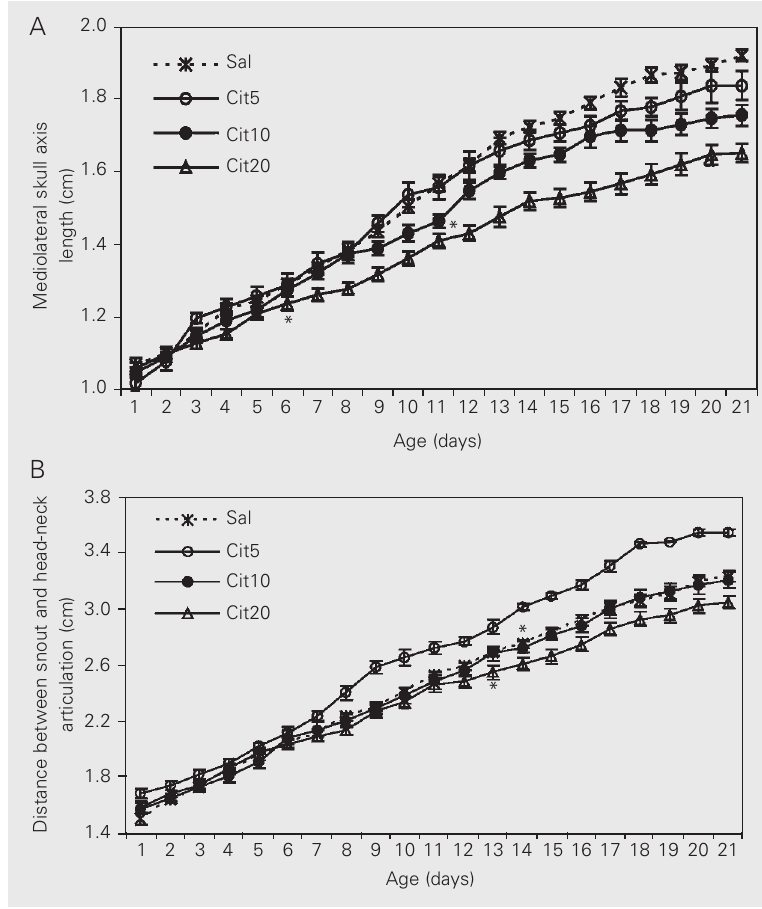
Figure 2. Effect of citalopram on suckling rat mediolateral skull axis length and distance between snout and head-neck articulation. A , Mediolateral skull axis from the 1st to 21st day of life of suckling rats treated with solutions (1 ml/100 g body weight, sc ) of citalopram: 5 mg (Cit5, N = 26), 10 mg (Cit10, N = 27) and 20 mg/kg (Cit20, N = 26) or saline (Sal, N = 27). Comparisons were made by two-way ANOVA for repeated measures for citalopram (F 3,102 = 23.8, P < 0.001) and day of life (F 20,2040 = 1622.1, P < 0.001) and citalopram versus day of life interaction (F 60,2040 = 15.3, P < 0.001) followed by post hoc multiple comparisons (Tukey test) between each citalopram dose and saline. The asterisks indicate the beginning of significant difference in the Cit10 group (P < 0.05) and Cit20 group (P < 0.001) that persisted to the end of the experiment. B , Distance between snout and head- neck articulation. Comparisons were made by two-way ANOVA for repeated measures: citalopram (F 3,102 = 15.1, P < 0.001), day of life (F 20,2040 = 2770.6, P < 0.001), and citalopram versus day of life interaction (F 60,2040 = 14.7, P < 0.001) followed by post hoc multiple comparisons (Tukey test) between each citalopram dose and saline. The